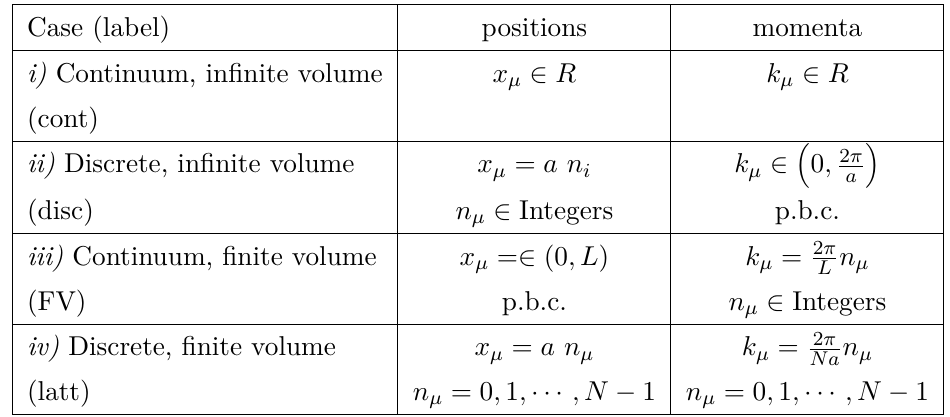
Table 1. Possible values of each component of positions and momenta for each one of the four cases